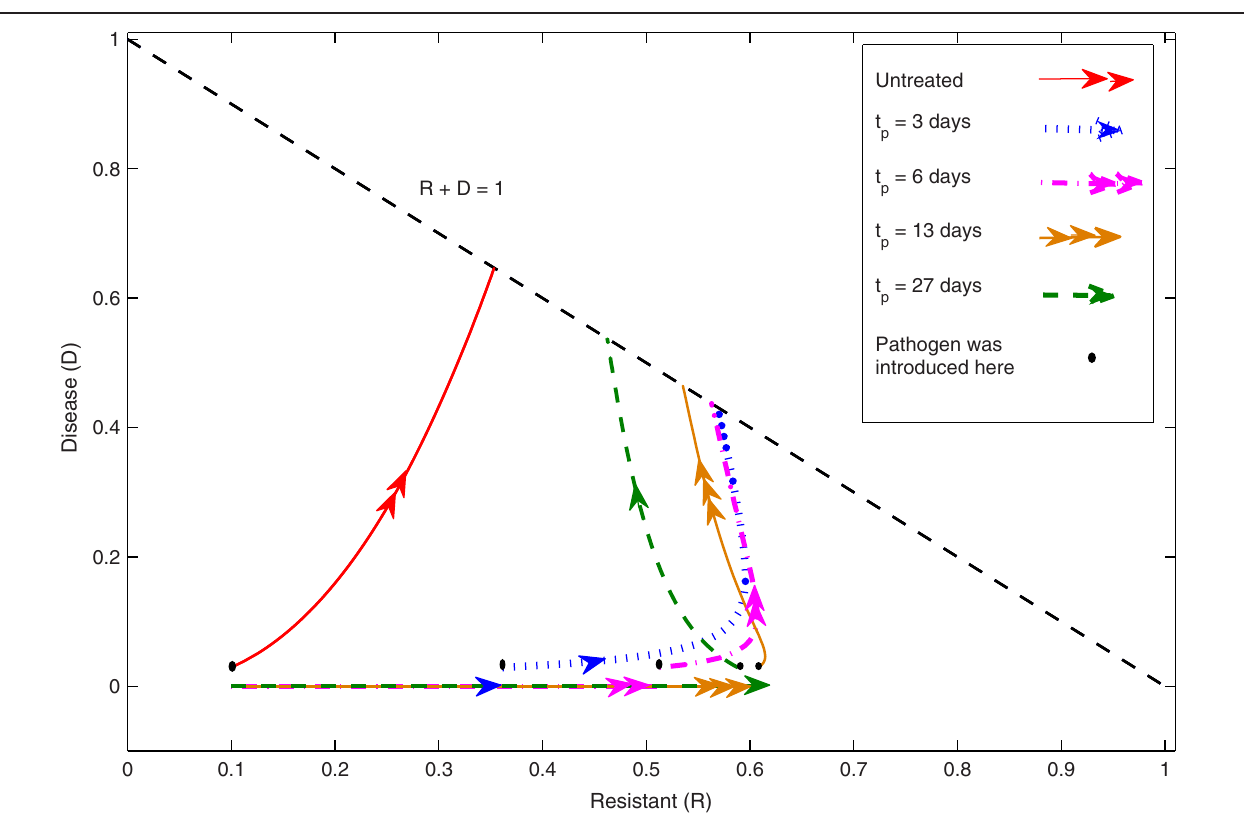
FIGURE 1 | The phase-plane for the induced resistance (IR) model. These trajectories of the R , D compartments are plotted in the feasible region ( R , D > 0 , R + D < 1 ) . The lines schematically represent the values of the two compartments R and D as time passes for the Equations (1)–(5) based on each induction case t p and the untreated case. When D = 0, the straight lines illustrate the dynamics of the R compartment before the pathogen inoculation. These lines will have a